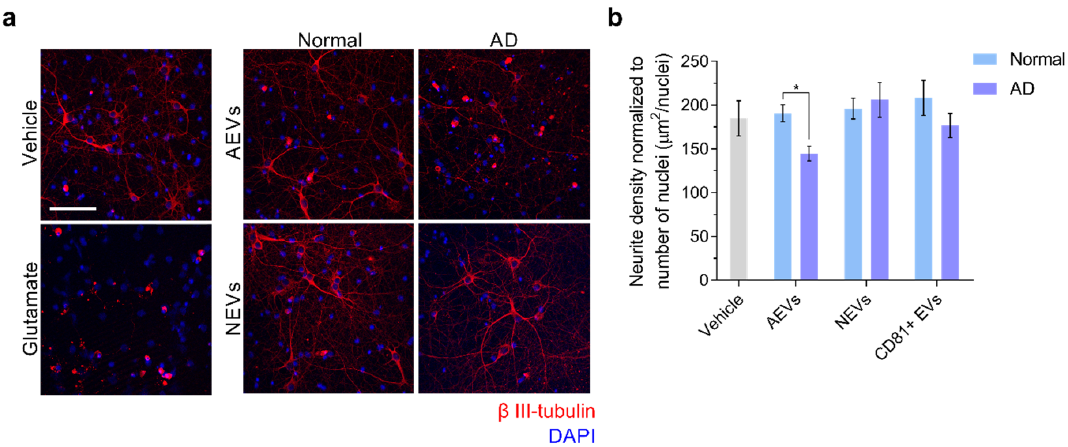
Figure 2. AD AEVs induce neurodegeneration. ( a ) Immunofluorescence of β III-tubulin (red) as an indicator of neurite density in E18 rat cortical neurons incubated with either AEVs or NEVs isolated from the plasma of AD patients and normal controls at 600 EVs/neurons for 48 h. Fluorescent confocal microscopy images at 25X magnification show that neuronal cultures treated with AEVs from AD participants exhibit decreased neurite density, compared to the vehicle-treated neurons and neurons treated with AEVs from normal participants, as well as with NEVs from AD and normal participants. Treatment with 100 μ M glutamate was used as a positive control for neurotoxicity. DAPI staining in blue shows the localization of nuclei. Scale bar, 100 μ m. ( b ) A bar graph showing the quantification of neurite density defined as the image area covered by β III-tubulin signal above the threshold normalized to the number of nuclei. Each bar represents the mean value ± SEM of 5–15 images, per treatment with NEVs, AEVs, and CD81+ EVs from 4 AD subjects and 3 normal participants in duplicates. There was significant neurite density decrease in the neurons treated with AEVs from AD compared to the normal participants (AD vs. Normal, p = 0.02); the difference was not observed in the NEV-treated ( p = 0.891) or CD81+ EV-treated neurons ( p = 0.252), suggesting a greater neurodegenerative potential for AEVs, compared to NEVs or CD81+ EVs. * p < 0.05.